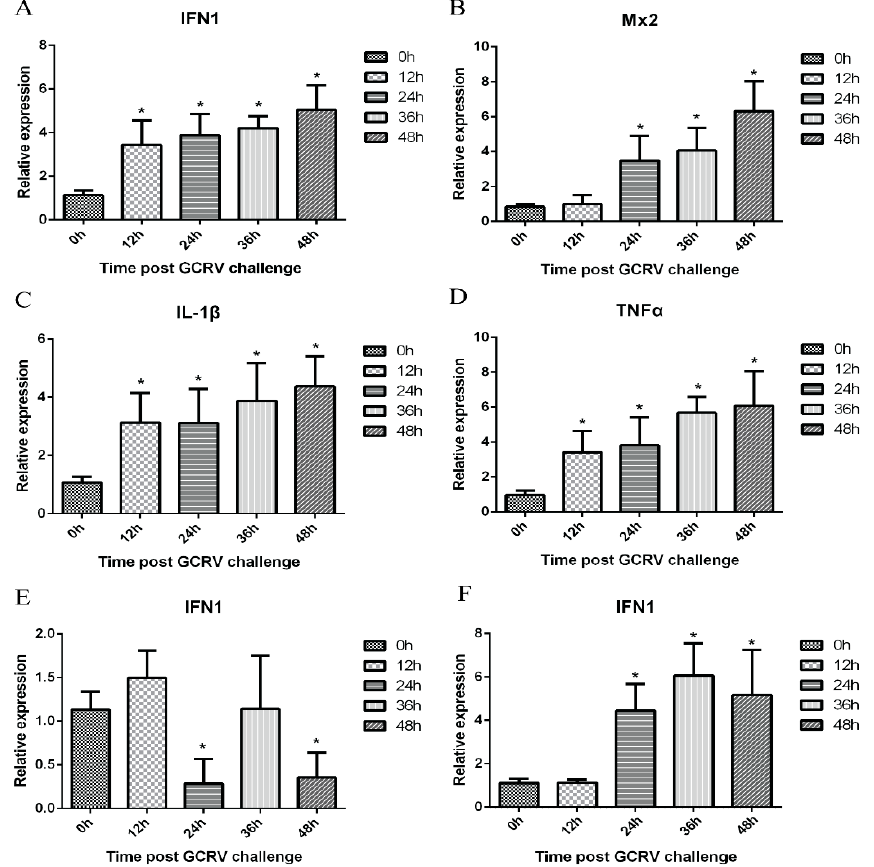
Figure 3. Leukocytic antiviral responses to GCRV-II infection. Expression of genes involved in antiviral responses was measured by qRT-PCR, use EF1 α as an internal reference gene. The expression levels in infected leukocytes in 6-well plates were challenged with GCRV for 0 h, 12 h, 24 h, 36 h, and 48 h. The relative increase for IFN1 ( A ), Mx2 ( B ), IL-1 β ( C ), and TNF α ( D ) is shown. ( E ) The expression levels of IFN1 in infected erythrocytes in 6-well plates were challenged with GCRV for 0 h, 12 h, 24 h, 36 h, and 48 h. ( F ) The expression levels of IFN1 in infected thrombocytes in 6-well plates were challenged with GCRV for 0 h, 12 h, 24 h, 36 h, and 48 h. Data of reporter assays and qPCR are shown as mean ± SD of 6 wells of cell per group and are from one experiment representative of three independent experiments. Significance was calculated in relation to the control group. * p < 0.05 (two tailed Student’s t -tests). The relative transcription levels were normalized to the transcription level of EF1 α gene and are represented as fold induction relative to the transcription level in control cells, which was set to 1.